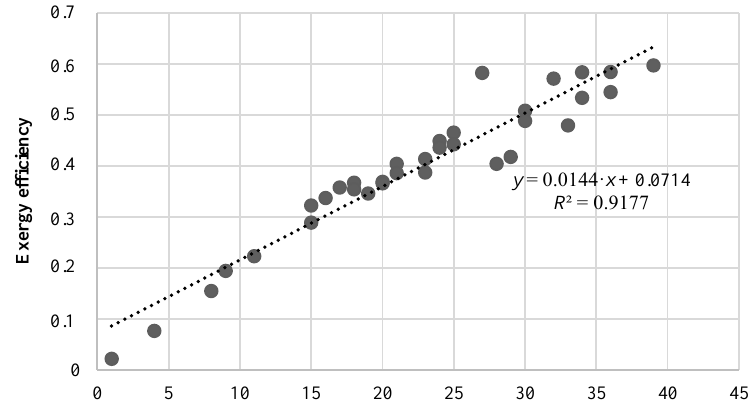
Fig. 4. Single-stage compressor refrigeration system exergy efficiency depending on ambient temperature and refrigerator temperature difference.